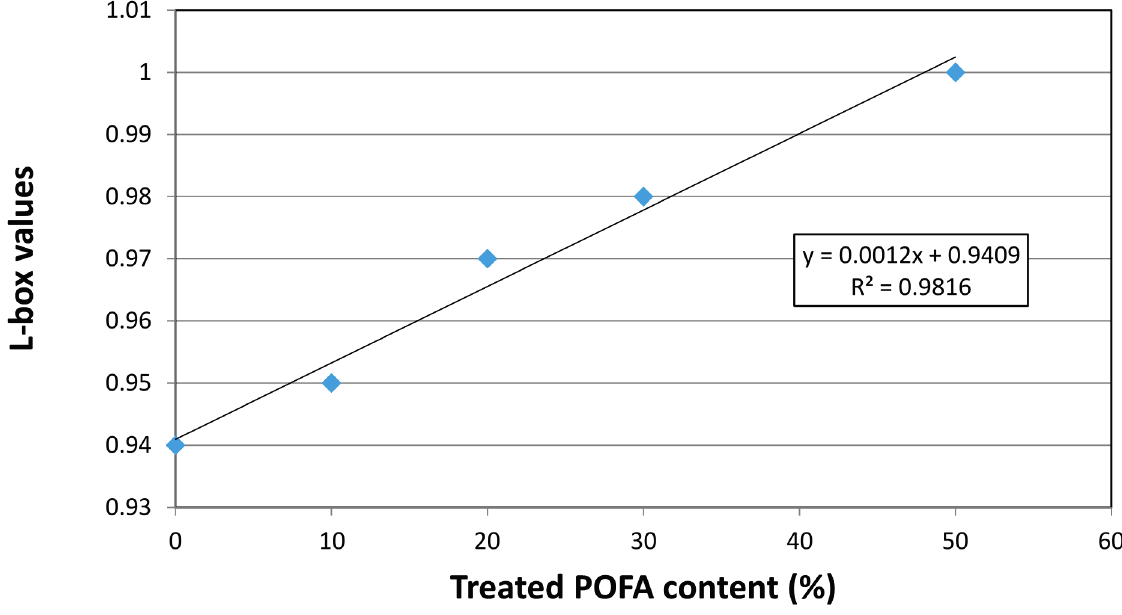
Figure 8. L-box for SCC with treated